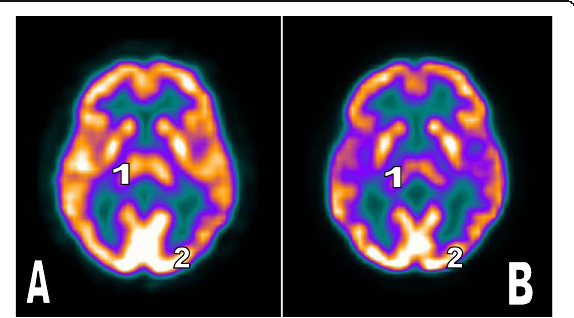
Fig. 2 Sixty-one-year-old female discovered to have breast carcinoma by prior CT, the patient came for PET/CT assessment. a , b Axial fused PET/CT images of the brain before and after chemotherapy. Fused axial PET/CT images show reduced FDG uptake in the post chemotherapeutic state (image B) compared to the pre-chemotherapeutic state (image a ) along the right thalamus